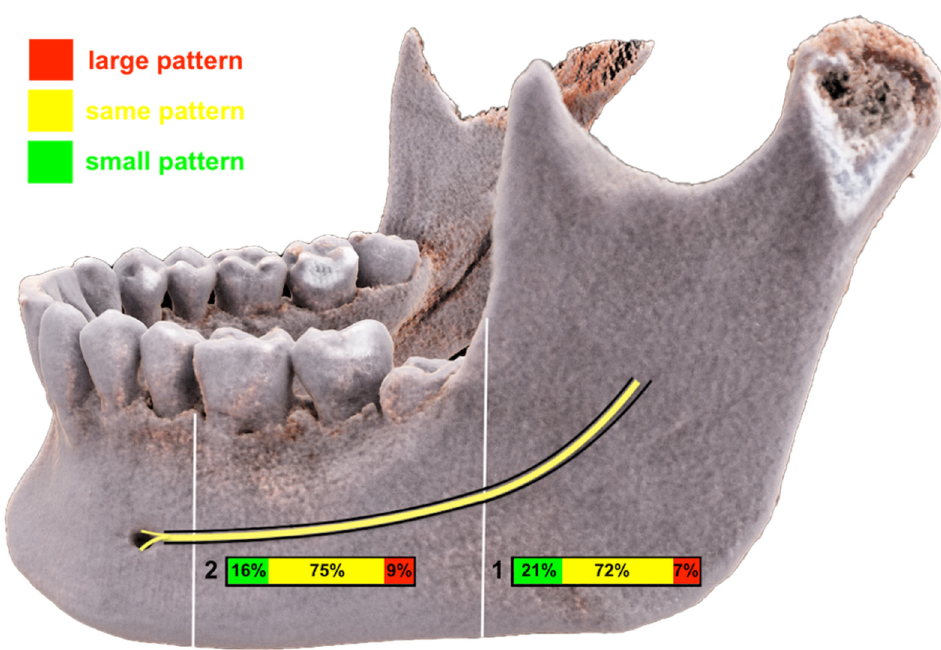
Figure 6. Photorealistic three-dimensional (3D) visualization of a study participant’s cone beam computed tomography (CBCT) using cinematic rendering (CR) image reconstructions, visualizing the quantitative evaluation of the imaging fusion pattern in the retromolar and molar region. Table 1. The inter ‐ and intra ‐ rater agreement regarding the classification of the positional relation ‐ ship between the IAN/MC and the MTM. Table 2. The interrater and intrarater agreement regarding the detectability of inflammatory processes is listed.